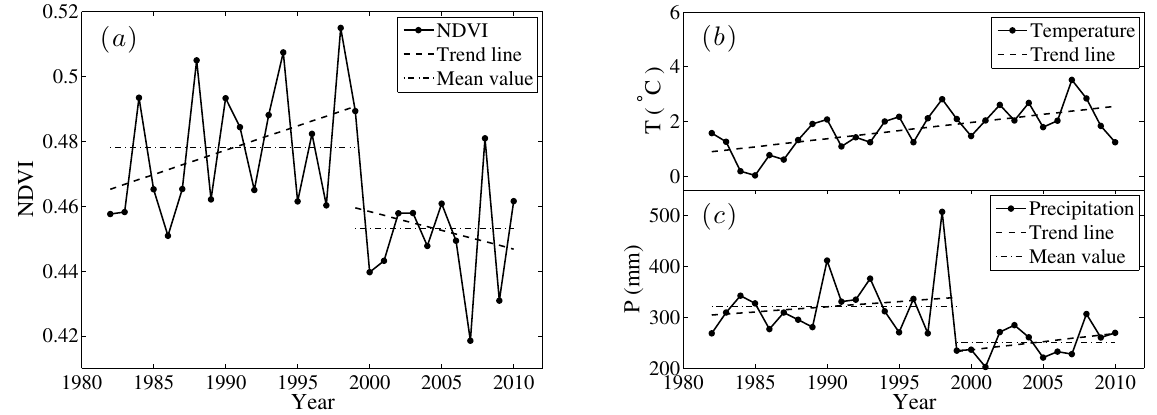
Figure 11. ( a ) Mean NDVI; ( b ) mean temperature and ( c ) accumulate precipitation in the growing season in northeast Inner Mongolia from 1982 to 2010.